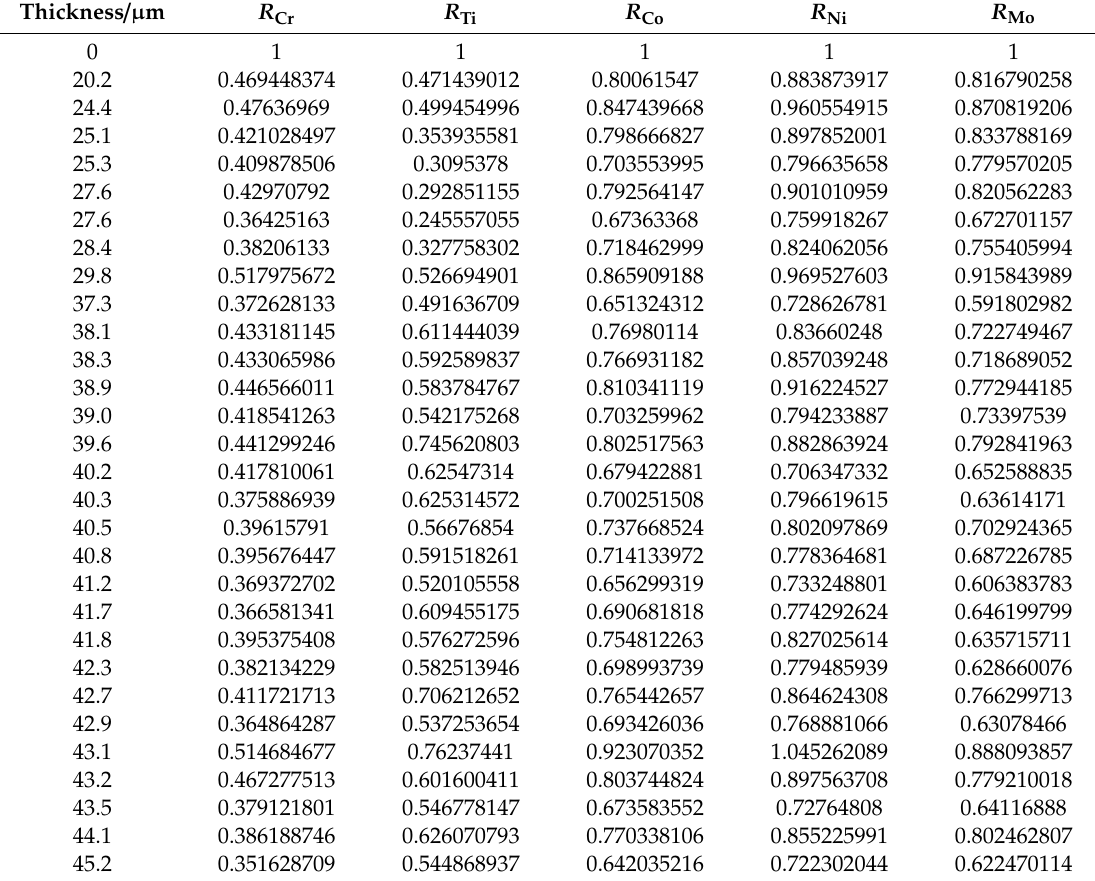
Table 4. Relative intensity ( R ) of each